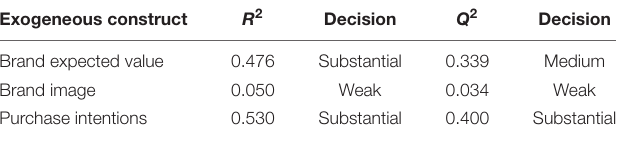
TABLE 4 | Coefficient of determination ( R 2 ) and predictive relevance ( Q 2